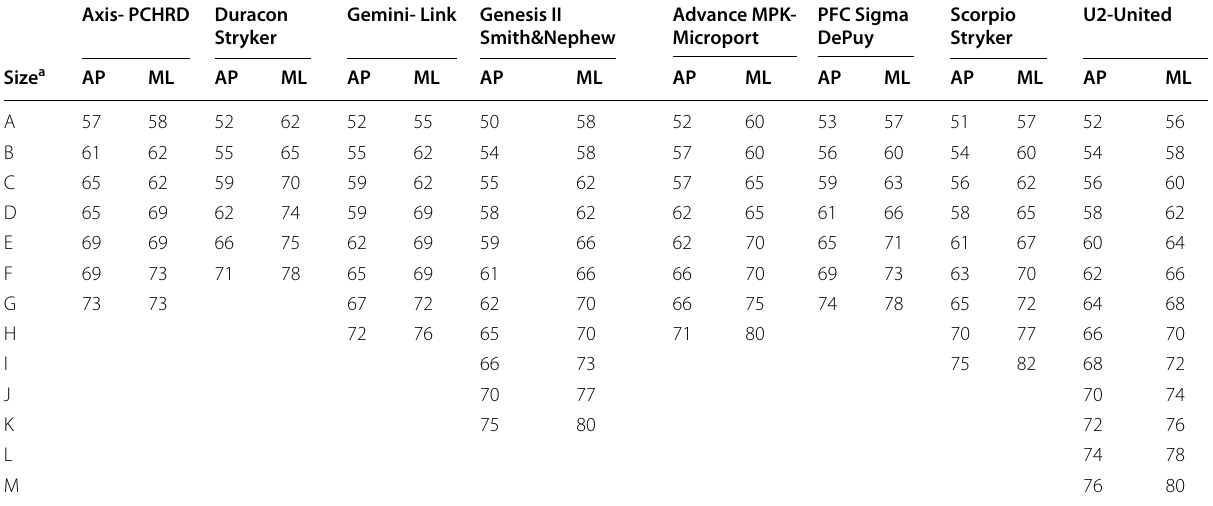
Table 6 Anteroposterior and mediolateral dimensions of TKR-femoral prostheses in the Philippine and Asian markets (in millimeters)